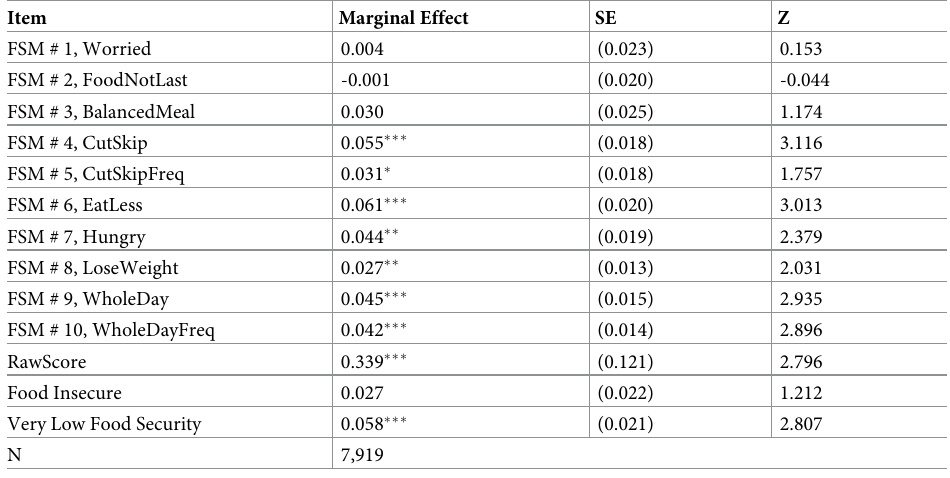
Table 3. Marginal effects of salience window on FSM items, raw score, food insecurity,